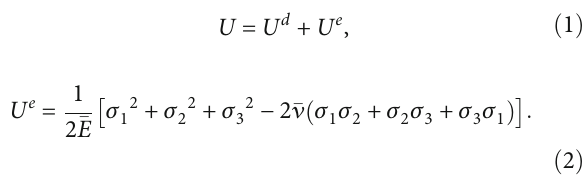
ff erent core t max with di